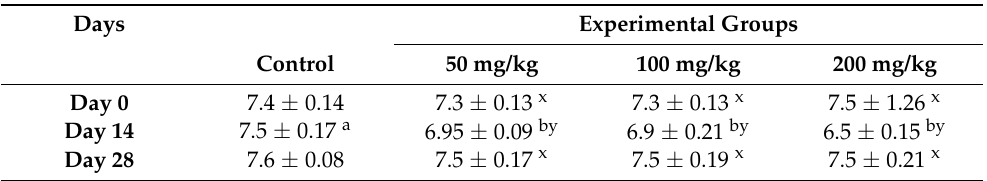
Figure 6. Mean serum LH levels in female albino rats exposed to graded doses of MSEAI at different time points. Table 2. Mean serum total protein values of female albino rats exposed to different doses of AI on day 0, 14 and